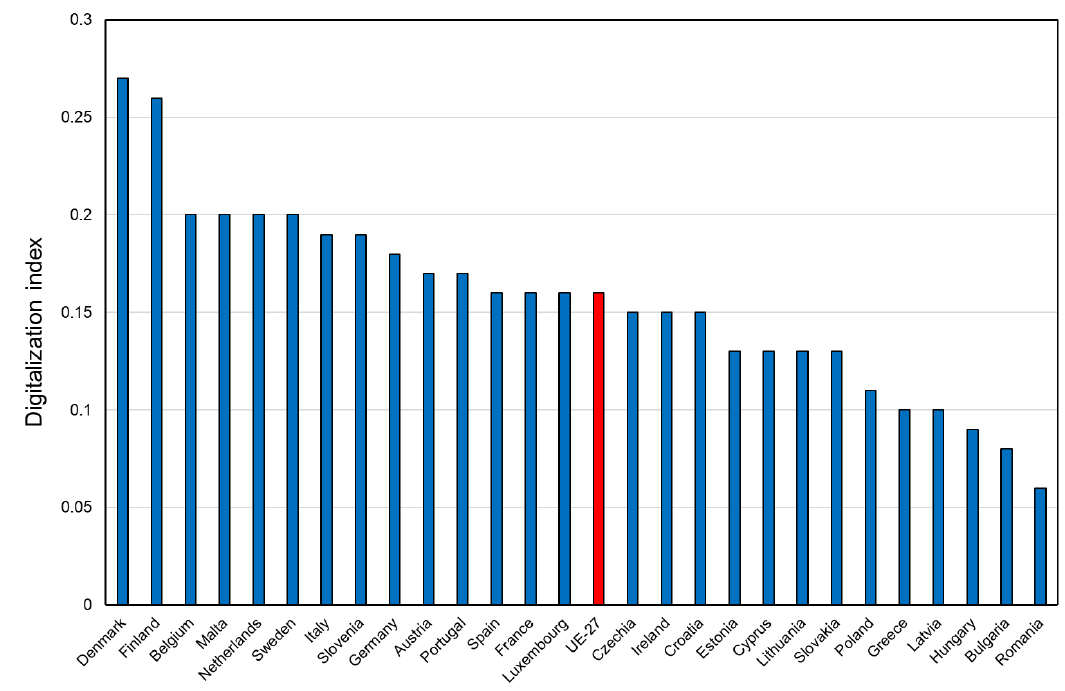
Figure 4. The digitalization index values for the EU-27 countries.